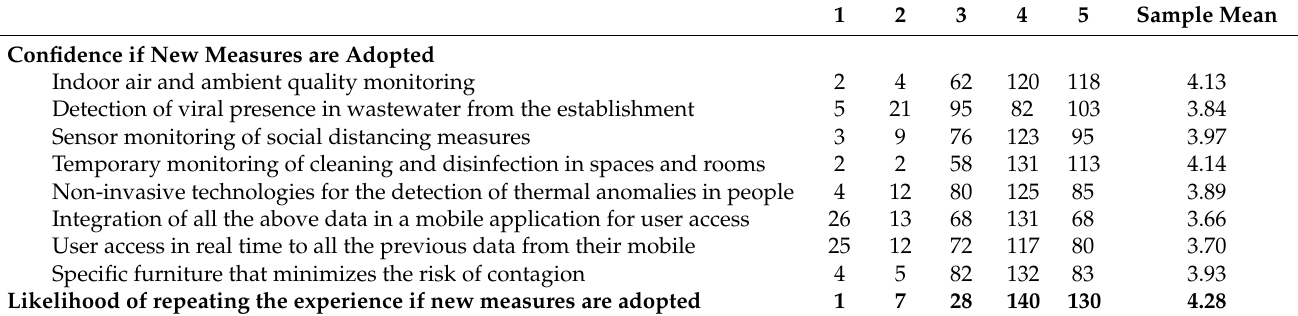
Table 5. Level of confidence and likelihood of repeating the experience in case of applying the following